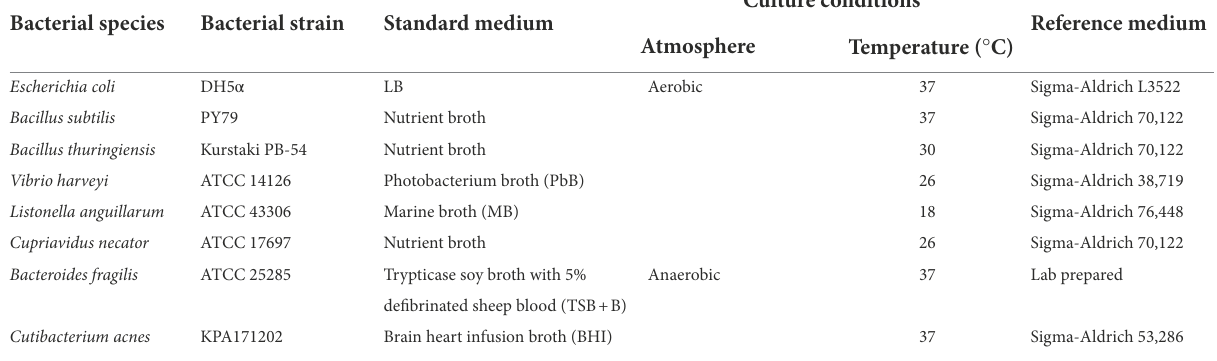
TABLE 2 List of microorganisms and corresponding reference culture media (according to ATCC) analyzed in this